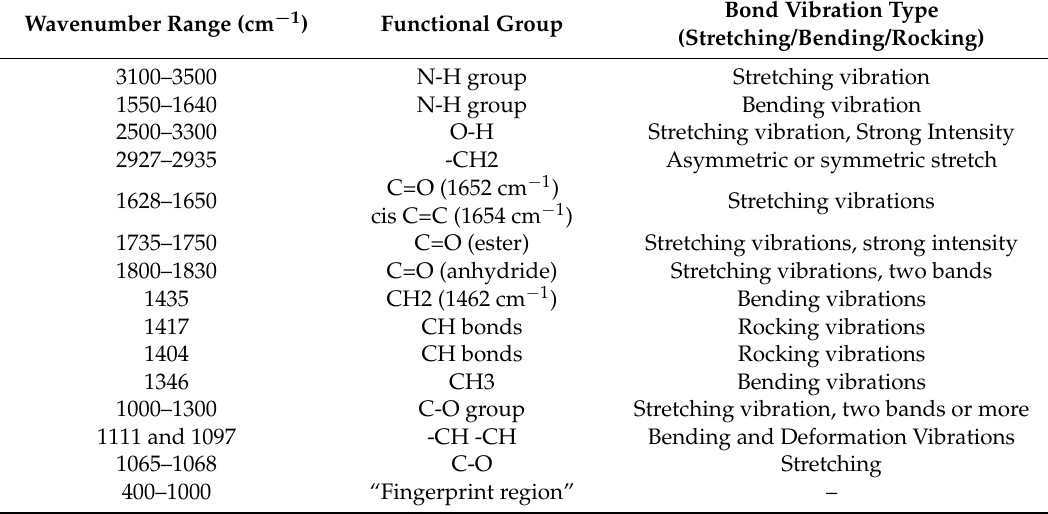
Table 5. Functional groups with their respective range of occurrence in wavenumbers